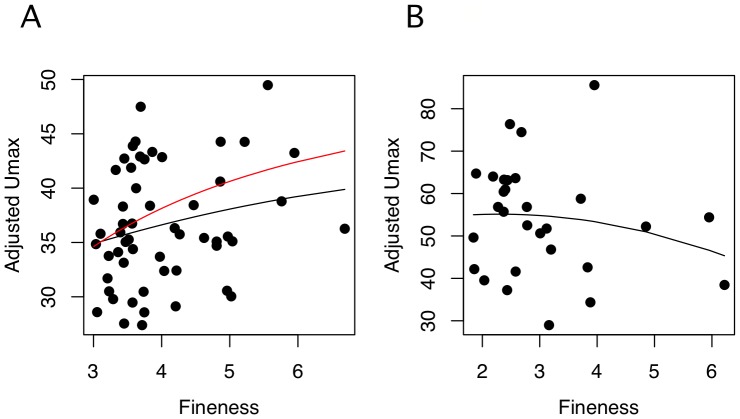
Maximum prolonged-swimming speed as a function of fineness in coral reef fishes.(A) pectoral-fin (MPF) and (B) body and caudal fin (BCF) subsets. The values are adjusted using the residuals from the regression of Umax on M
1/3 and AR (fin aspect ratio). The red line is the modeled U
max (eq. 2). The black lines are the quadratic fit of the adjusted Umax on fineness (f).